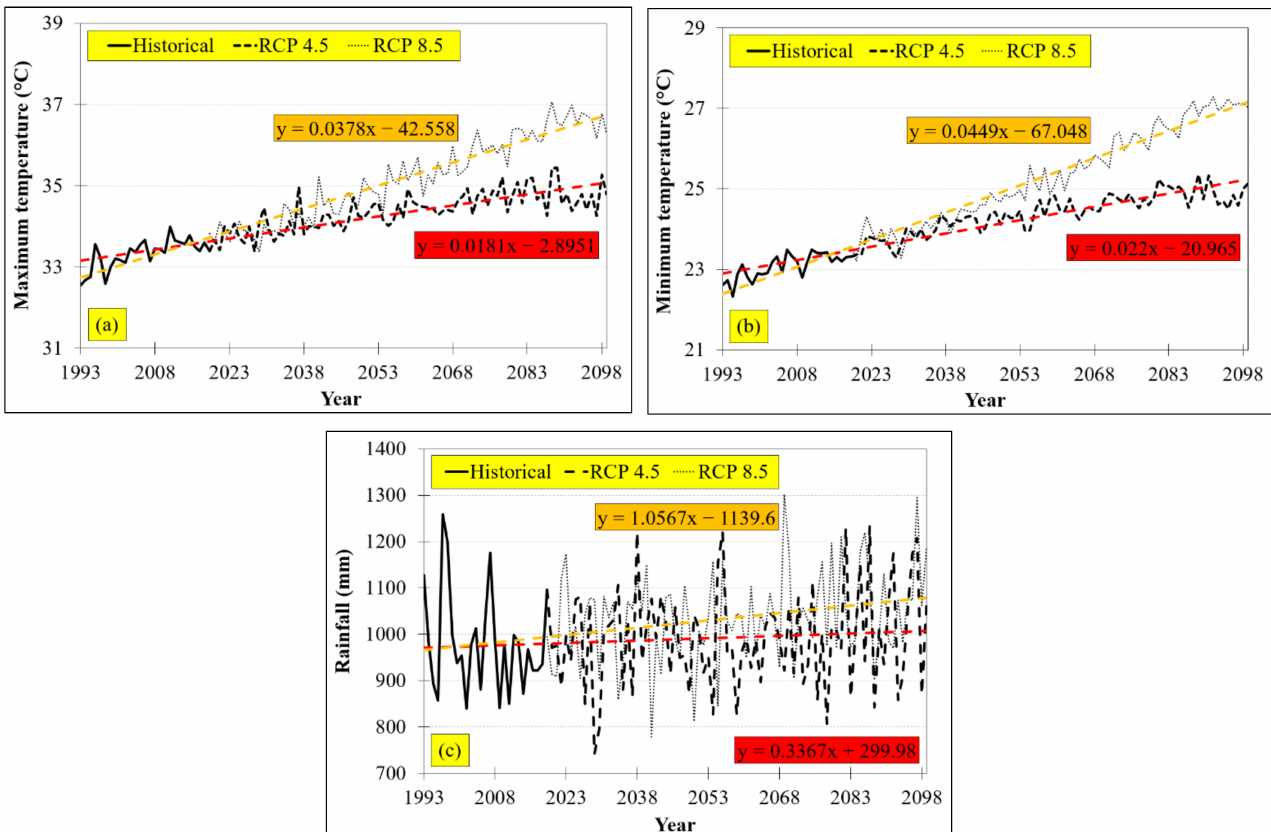
Figure 2. Projected average annual maximum and minimum temperature ( a , b ) and projected average annual rainfall ( c ) under RCPs 4.5 and 8.5 until the end of the century in the Lam Takong River